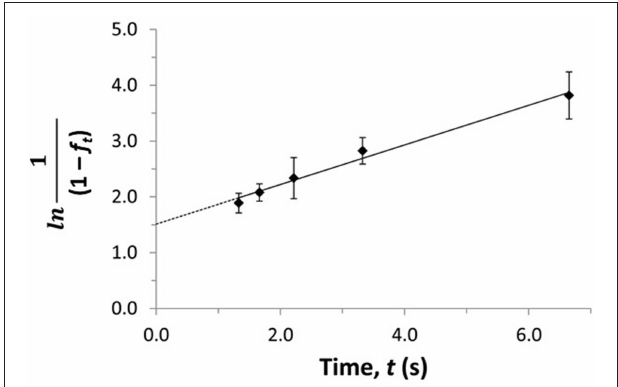
FIGURE 12 | Plot of ln[1/(1– f t )] vs. t to estimate the dissociation rate constant for verapamil with soluble HSA by using ultrafast affinity extraction and Equation (14). Terms: f t , apparent free fraction for the analyte measured at a given dissociation time; t , dissociation time. Adapted with permission from Zheng et al. (2014b). Copyright 2014 American Chemical